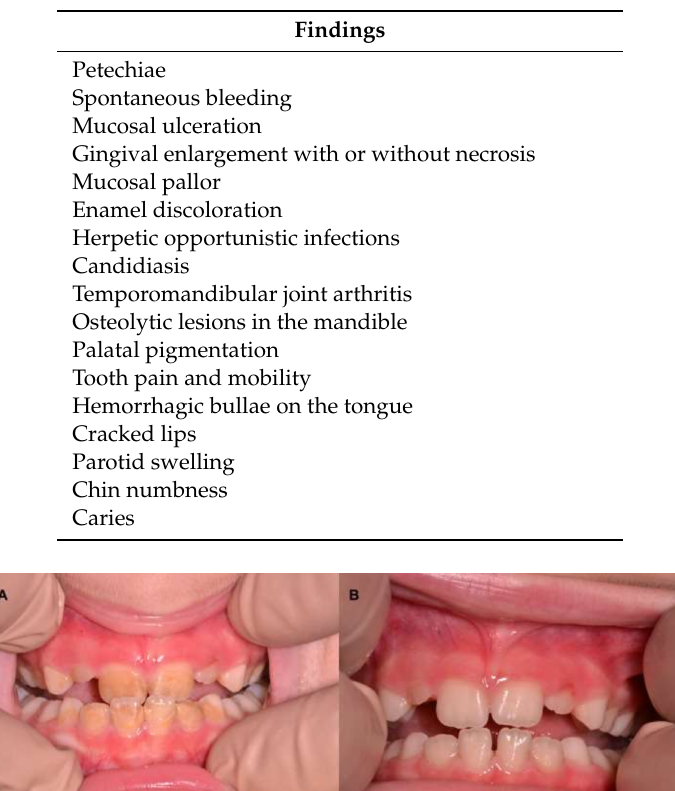
Table 1. Soft and hard tissue alterations in acute myeloid leukemia (AML).